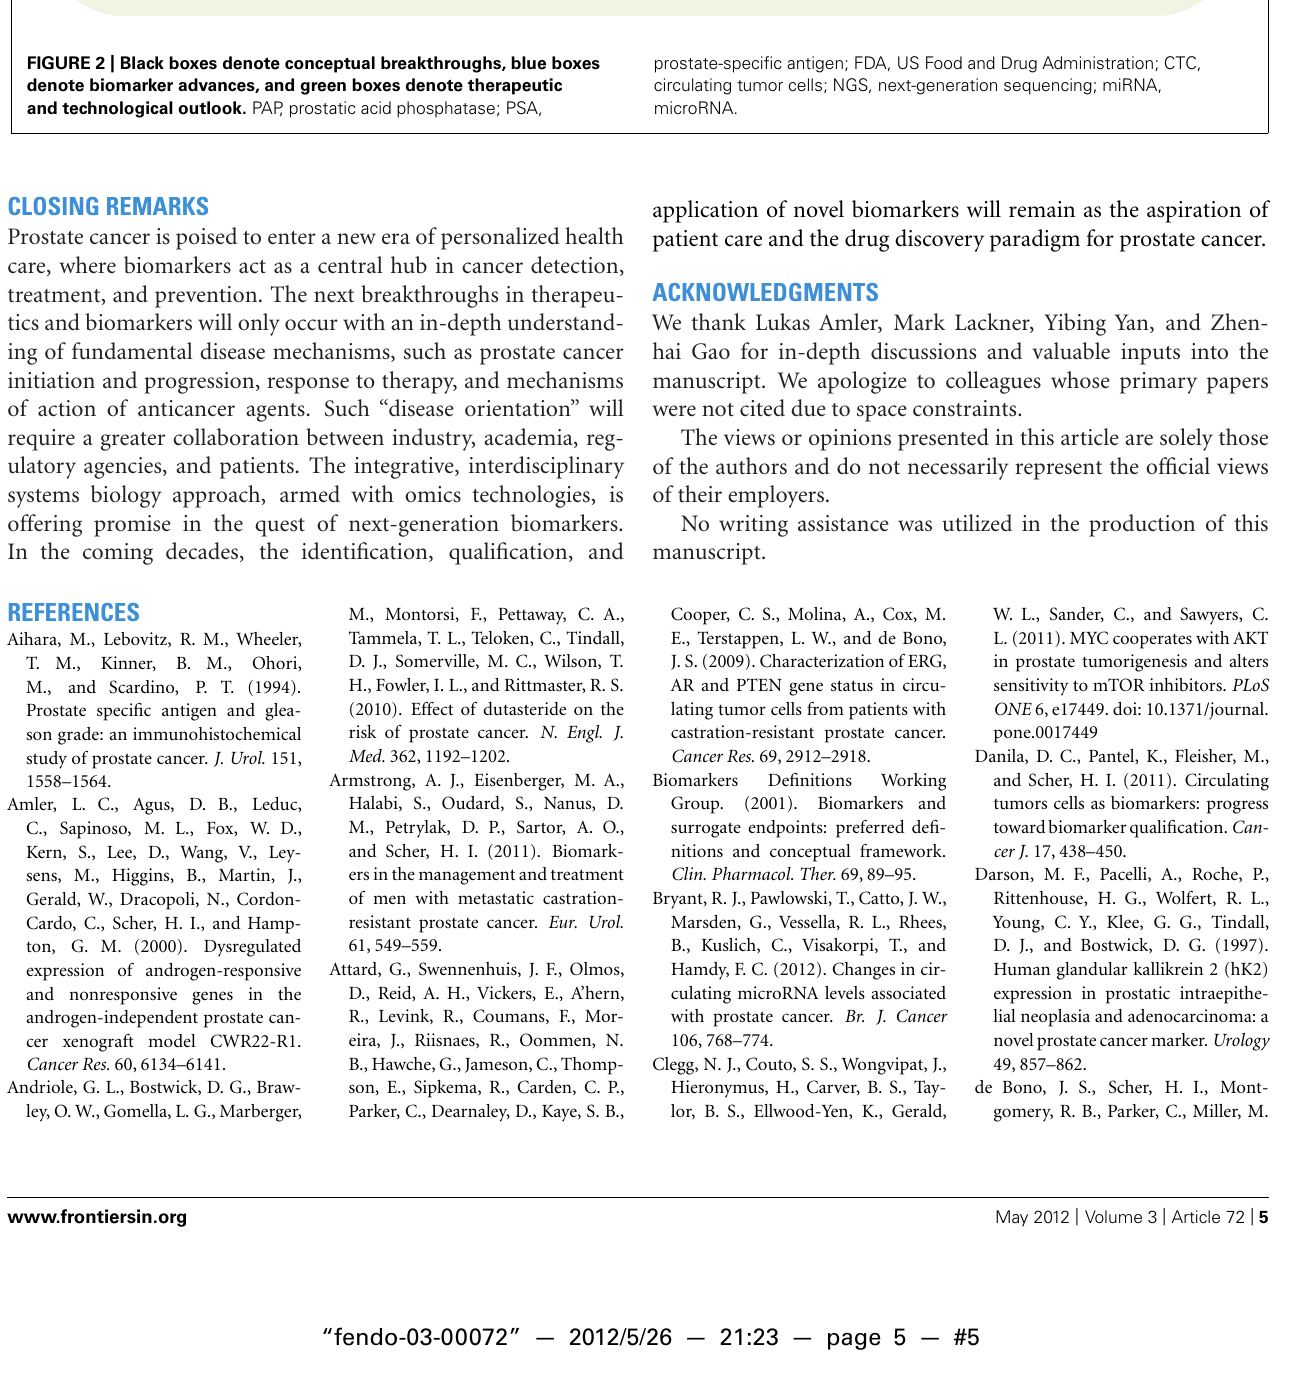
FIGURE 2 | Black boxes denote conceptual breakthroughs, blue boxes denote biomarker advances, and green boxes denote therapeutic and technological outlook. PAP, prostatic acid phosphatase; PSA,